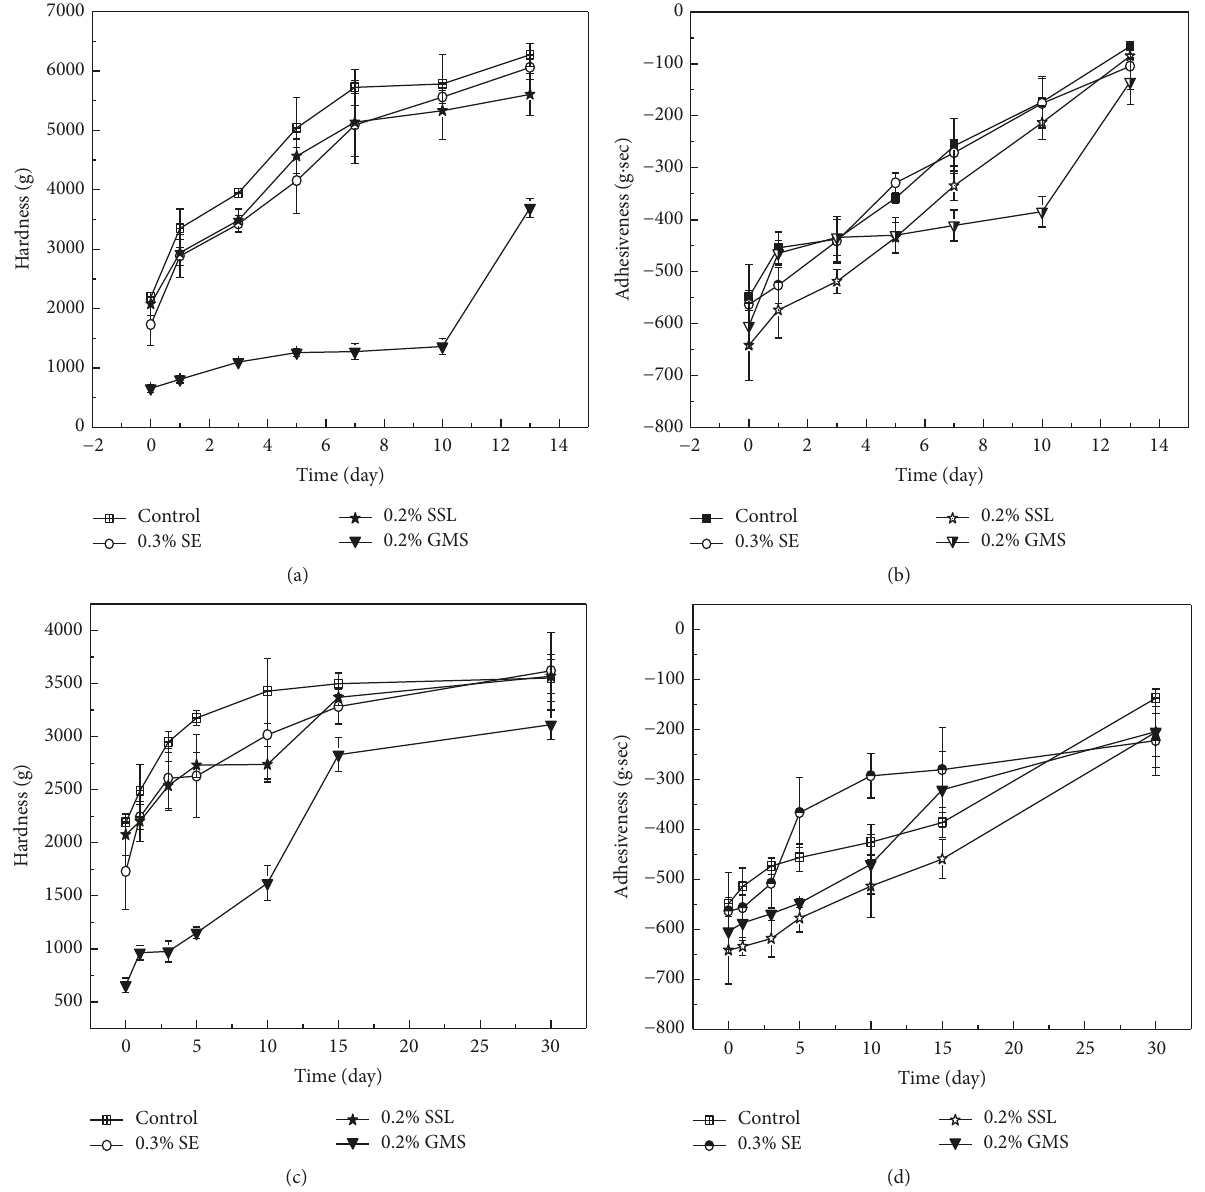
Figure 2: Hardness and adhesiveness of rice gels with different time storage at 4 ∘ C ((a), (b)) and − 20 ∘ C ((c), (d)). Error bars indicate standard